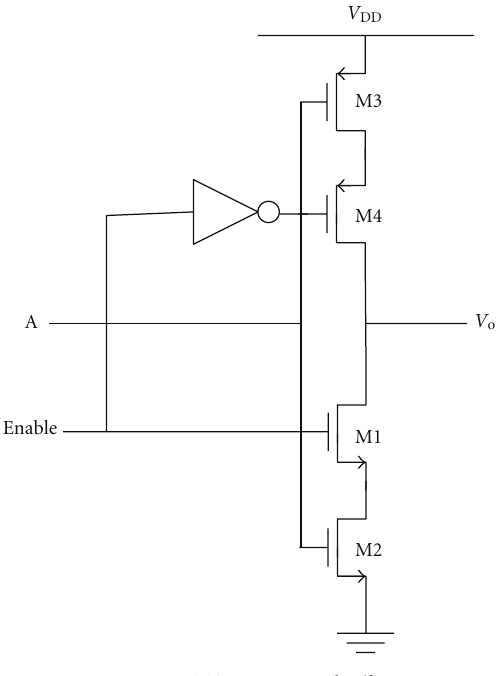
Figure 3: Tristate CMOS bu ff er .